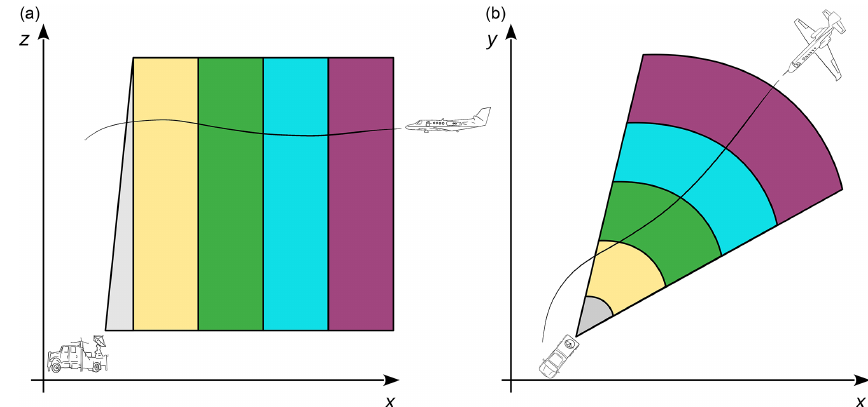
Figure 3. A schematic illustration from the collocation of RSVP columns with in situ measurements. Each colored column can be created according to the RSVP procedure depicted in Fig. 1. Gray shaded areas represent omitted data very close to the radar. Panel (a) shows the side view and panel (b) the top view of the aircraft flying through the columns.